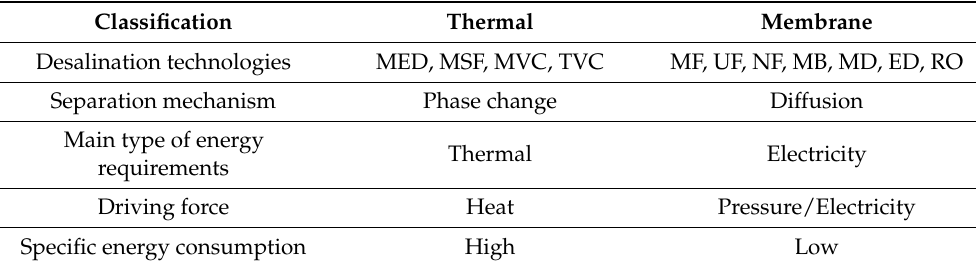
Table 2. Overview of desalination technologies